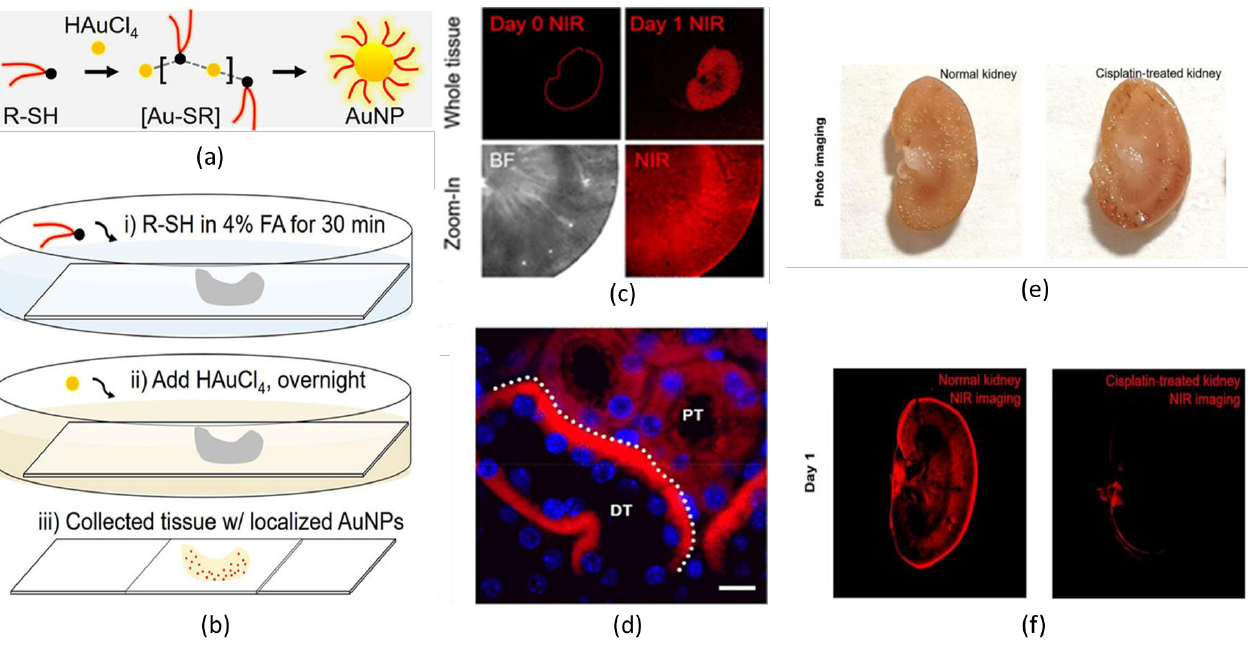
Figure 2. ( a ) Standard synthesis of GSH-AuNCs in solution. ( b ) Synthetic steps to perform precipitation of GSH-AuNCs inside biological tissue. ( c ) NIR fluorescence bioimaging of the whole kidney before (Day 0) and after (Day 1) the precipitation of GSH-AuNCs and zoom-in images of kidney cortex in both bright field (BF) and NIR imaging. ( d ) Confocal fluorescence microscopy imaging of kidney slides shows a preferential precipitation of GSH-AuNCs in the basolateral side of cytoplasm area in the renal distal tubule (DT) rather than in proximal tubule (PT) (Scale bar 10 μm). ( e ) Photos and ( f ) NIR fluorescence bioimaging of normal kidney and diseased kidney (artificially caused by overexposure to cisplatin) after (Day 1) the precipitation of GSH-AuNCs. Adapted with permission from Ref. [69] . Copyright 2019 American Chemical Society.